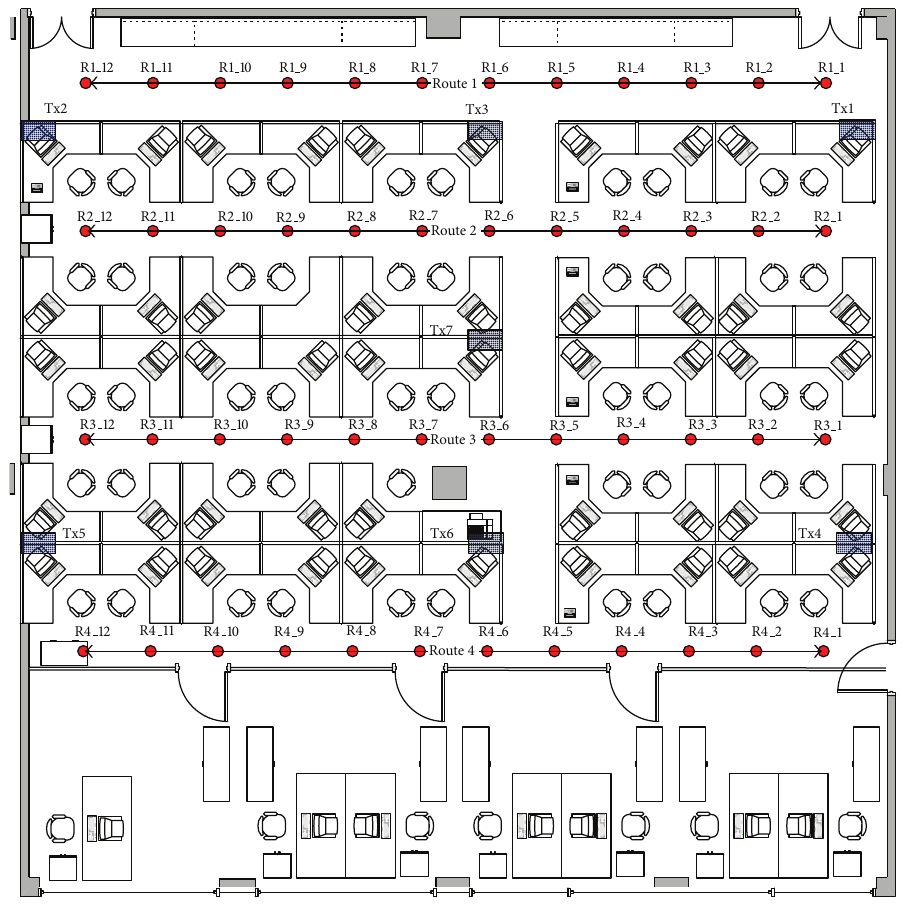
Figure 2: Floor plan of the measurement area in office scenario.